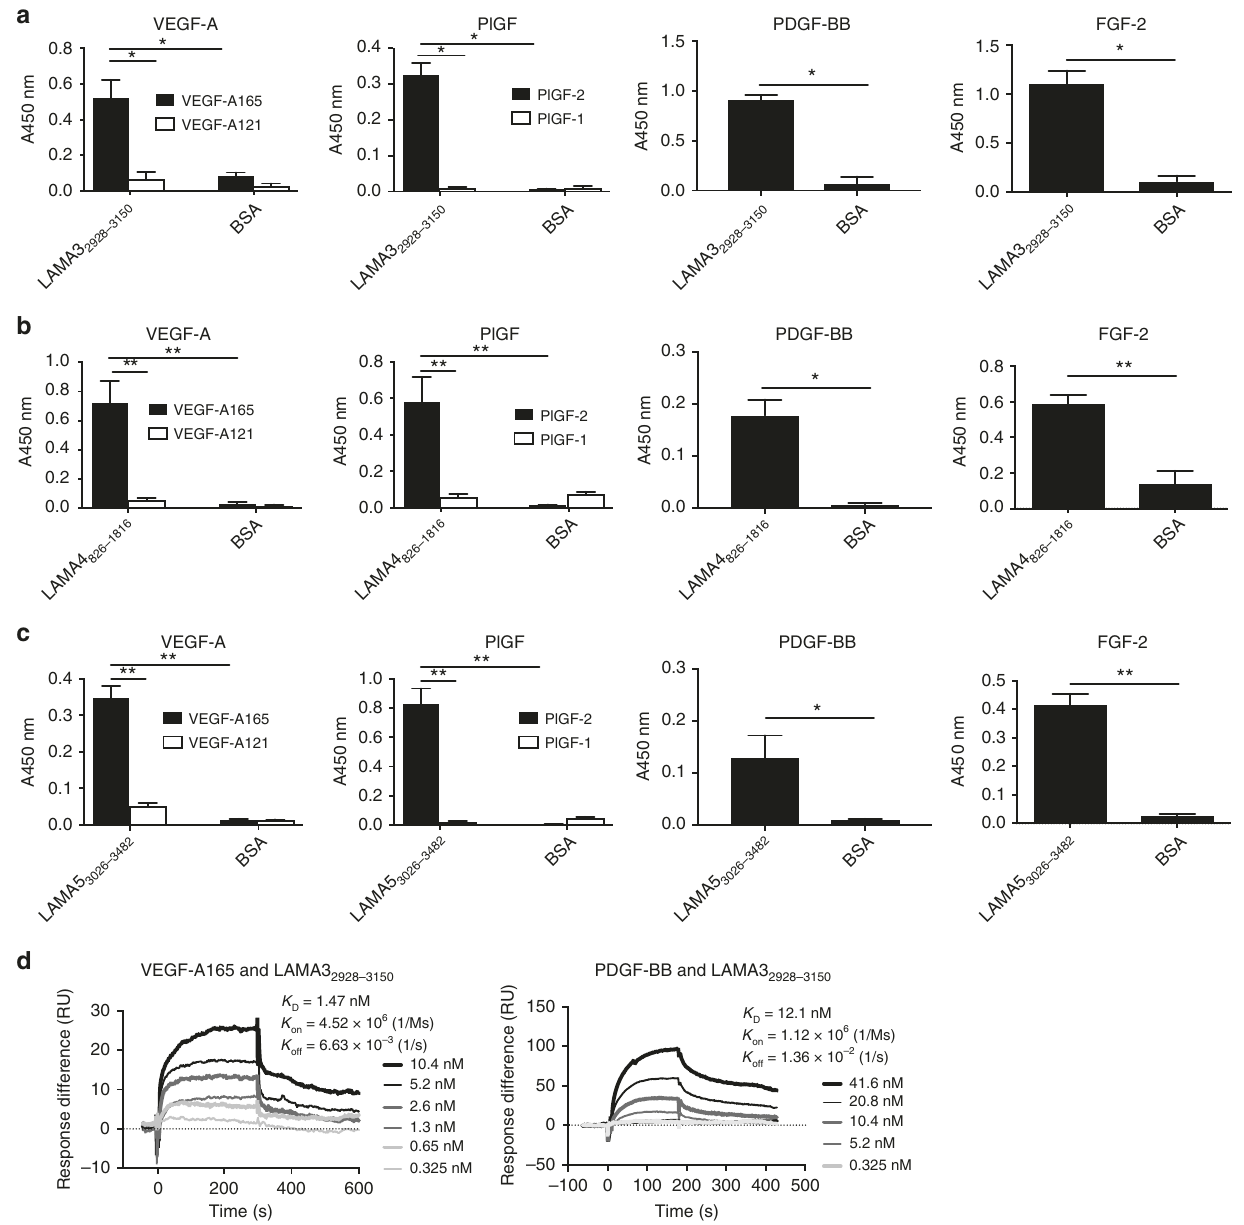
Fig. 3 GFs bind to LG domain derived from LAMA3, LAMA4, and LAMA5. Af fi nity of GFs against recombinant laminin LG domains. ELISA plates were coated with 1 µ g/mL a LAMA3 2928 – 3150 , b LAMA4 826 – 1816 , or c LAMA5 3026 – 3482 and further incubated with 1 μ g/mL of VEGF-A165, VEGF-A121, PlGF-2, PlGF-1, PDGF-BB, or FGF-2 solution. Bound GFs were detected using a speci fi c antibody for each GF ( n = 4, mean ± SEM). Statistical analyses were performed using the Mann – Whitney U test by comparing the signals obtained from the laminin domain- and the BSA-coated wells. * p < 0.05, ** p < 0.01. d Af fi nities ( K D values are shown) of laminin LAMA3 2928 – 3150 against VEGF-A165 and PDGF-BB were measured by SPR. A SPR chip was functionalized with the laminin LAMA3 2928 – 3150 recombinant protein (~1000 RU), and each GF was fl own over the chip at indicated concentrations. Curves represent the speci fi c responses (in RU) to laminin. Experimental curves were fi tted with Langmuir binding kinetics. Binding kinetics values [dissociation constants ( K D ) and rate constants ( K on and K off )] determined from the fi tted curves are shown. Two experimental